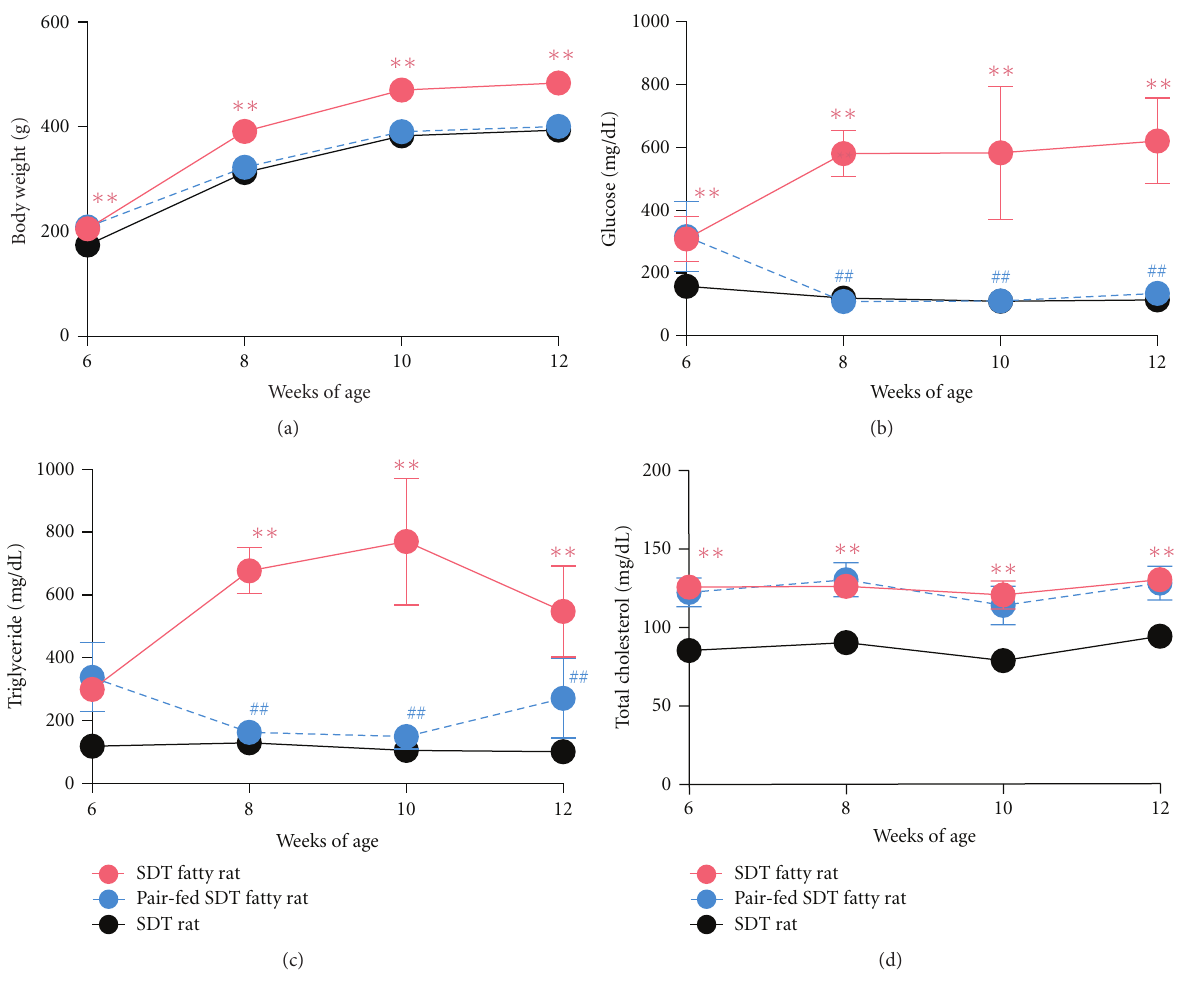
F 2: Changes in body weights (a) and serum parameters (b) glucose; (c) triglyceride; (d) total cholesterol) in SDT fatty rats, pair-fed SDT fatty rats, and SDT rats. Data represent mean signi�cantly di�erent from SDT